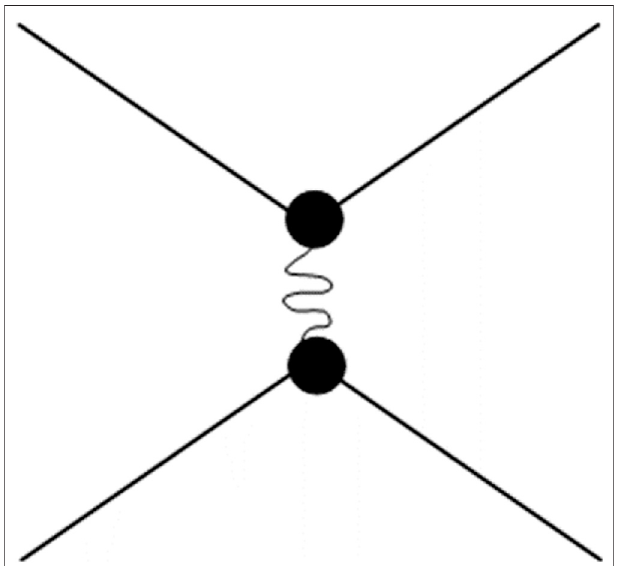
FIGURE5| Theorthorhombic-to-monoclinicphasetransitiononcooling coincides with formation of secondary van der Waals bonds (as represented here by a spring) between 2-fold oxygens from the neighboring octahedra- tetrahedra motifs. Asymmetric framework librations freeze out at the phase transition to the monoclinic form.